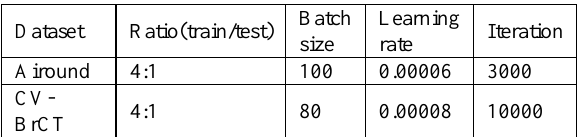
Table 1. Parameters of cross-modal model training